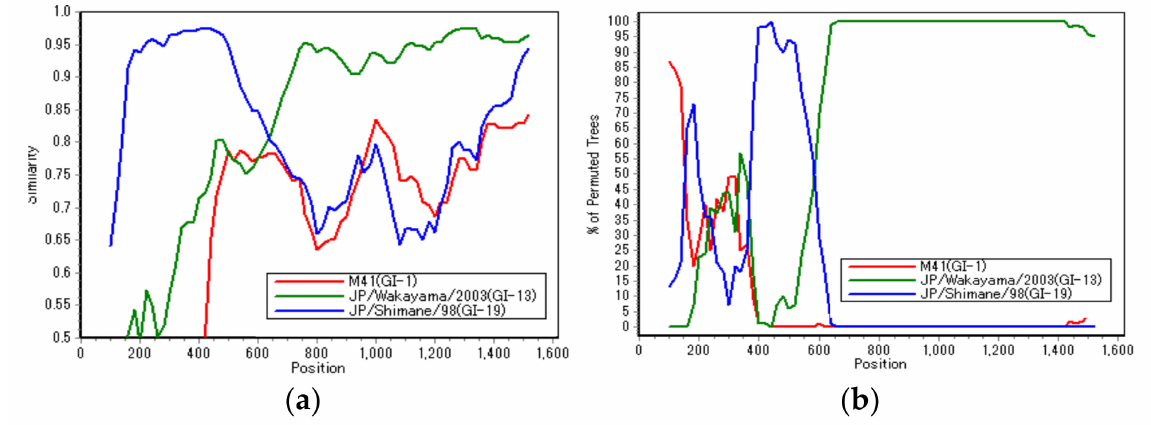
Figure 2. Similarity analysis ( a ) and BootScan analysis ( b ) on the putative recombinant JP/Nagasaki/2013 strain. Reference strains JP/Wakayama/2003 (GI-13, green) and JP/Shimane/98 (GI-19, blue) strains were used as putative parental strains. Additionally, the M41 strain (G1-1, red) was used as an outlier sequence. The y -axis indicates the percentage of identity within a 200-bp wide sliding window centered on the plotted position, with a step size of 20 bp between